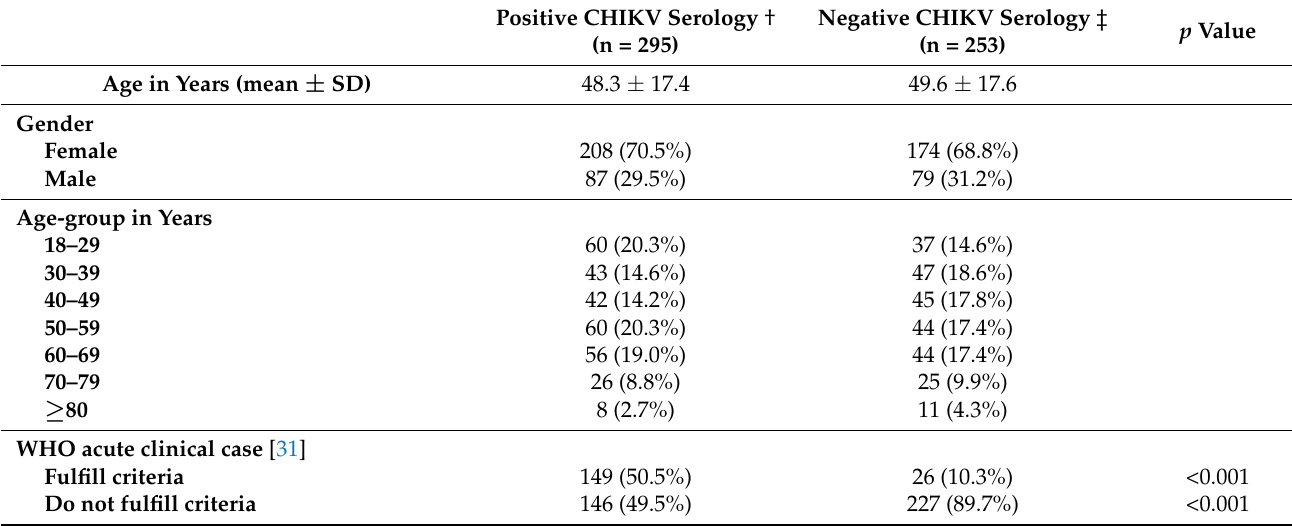
Table 1. Demographics in patients with suspected CHIKV